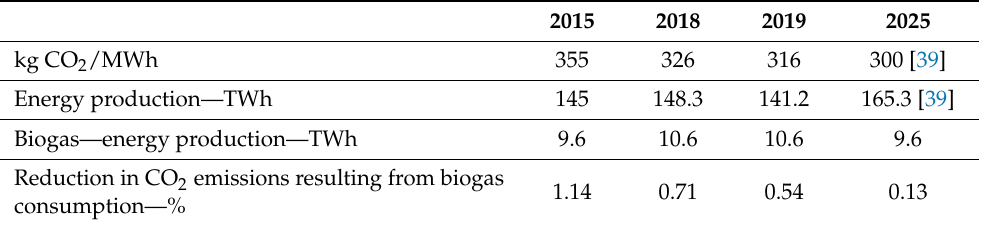
Table 5. The impact of biogas on the reduction in CO 2 emissions in Ukraine. Source: Own